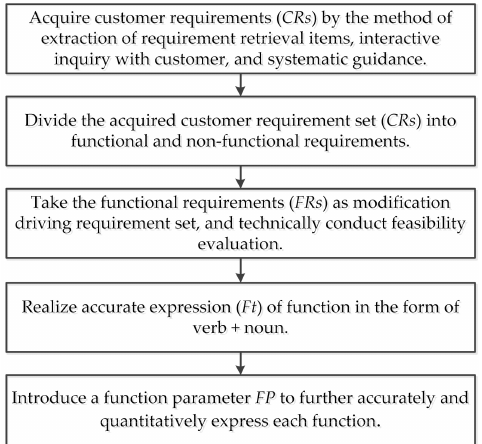
Figure 2. Flow of hierarchical analysis of